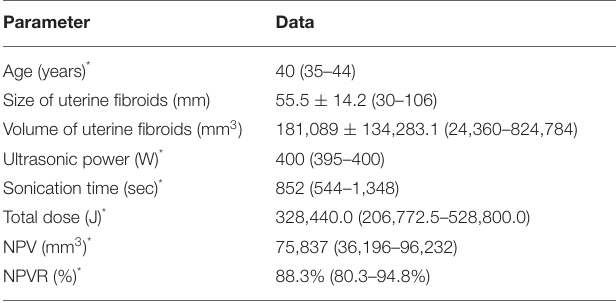
TABLE 1 | Baseline characteristics and the results of ultrasound ablation.